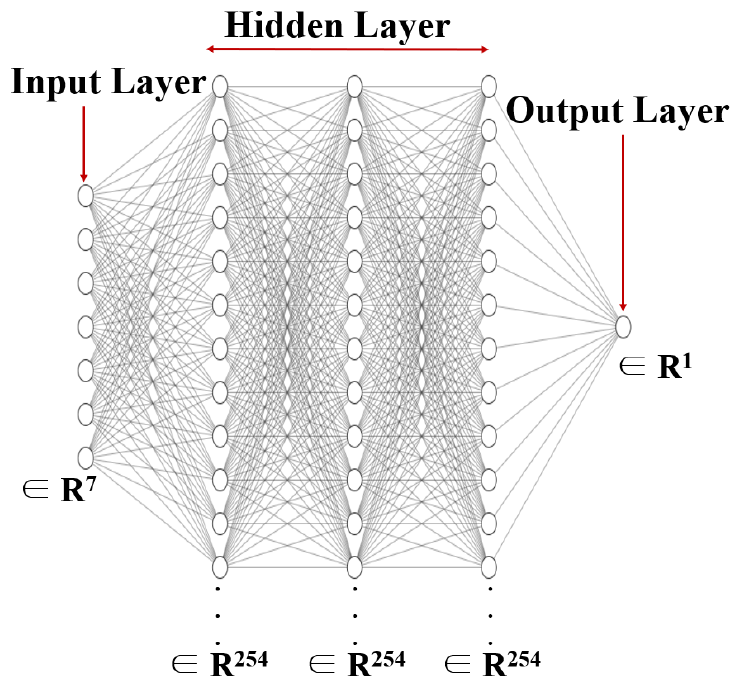
Figure 13. Neural network architecture used in the present study.